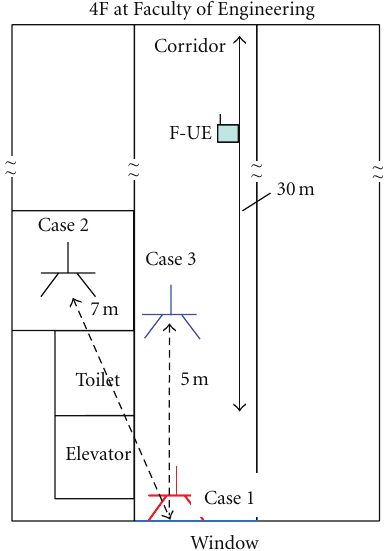
Figure 10: Location of femto-BS.